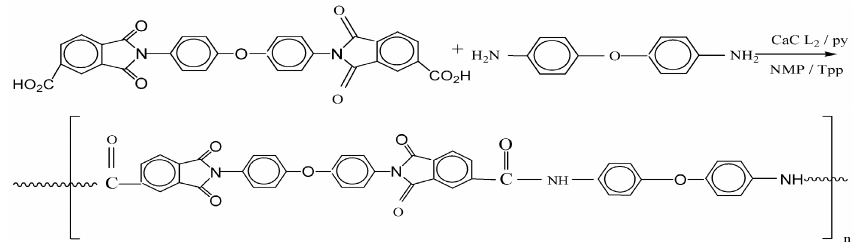
Figure 1. Synthetic route of Bis (4-N-trimellitylimido)diphenyl ether 3.